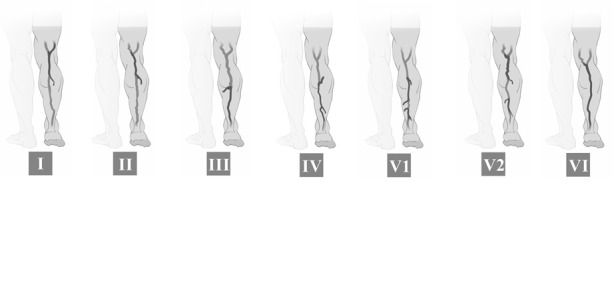
Patterns of reflux in the small saphenous vein: I) Medial junction reflux pattern; II) Proximal reflux pattern; III) Distal reflux pattern; IV) Segmental reflux pattern; V1) Multisegmental pattern without reflux at SPJ; V2) Multisegmental pattern with reflux at SPJ; VI) Diffuse reflux pattern.